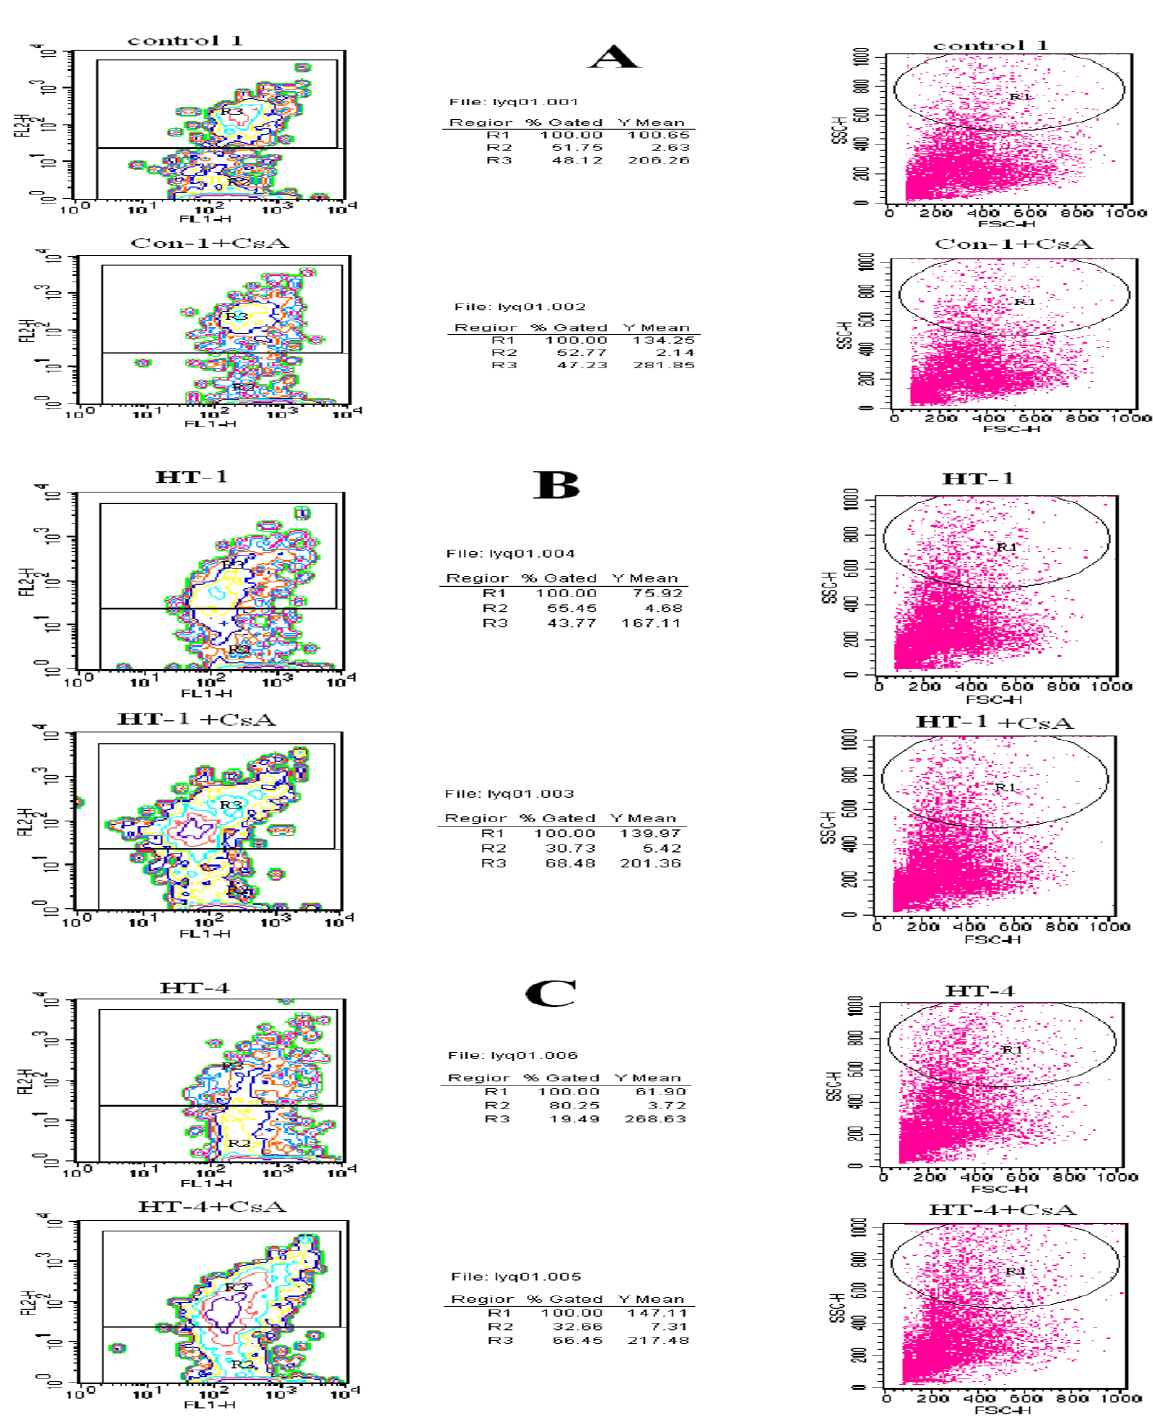
Mitochondrial potentials ( ΔΨ ) of cell lines from III-14, III-19 and from controls analyzed by flow cytometry . m The left and right figures show ΔΨ detected by flow cytometry before and after incubation with CsA (2 μ M) for 30 min, m respectively. A, cell lines of the control group; B, III-14; C,